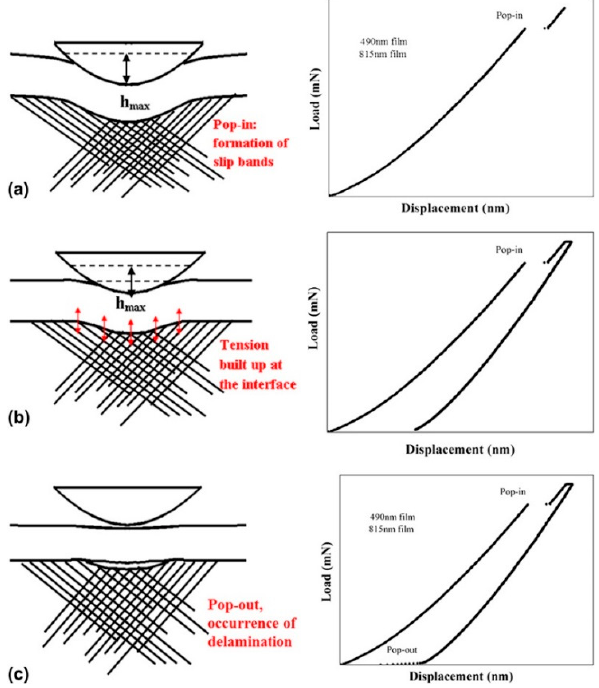
Figure 7. Schematic illustration of deformation mechanisms in metallic multilayers as a function of layer thickness from micrometer to nanometer range. ( a ) During the loading process, both the film and the substrate are deformed. When the stress on the substrate reaches the threshold, the substrate begins to produce a slip band, resulting in “pop-in”. ( b ) During the unloading process, both the film and the substrate are elastically restored, and a phase tension is formed at the interface due to the elastic mismatch between the film and the substrate and the difference in the existing plastic deformation; ( c ) When the tensile stress exceeds the interface strength, delamination occurs, and the peeling film elastically recovers upward during the unloading process. This speeds up the tip extraction, causing the unloading curve to “pop-out”.